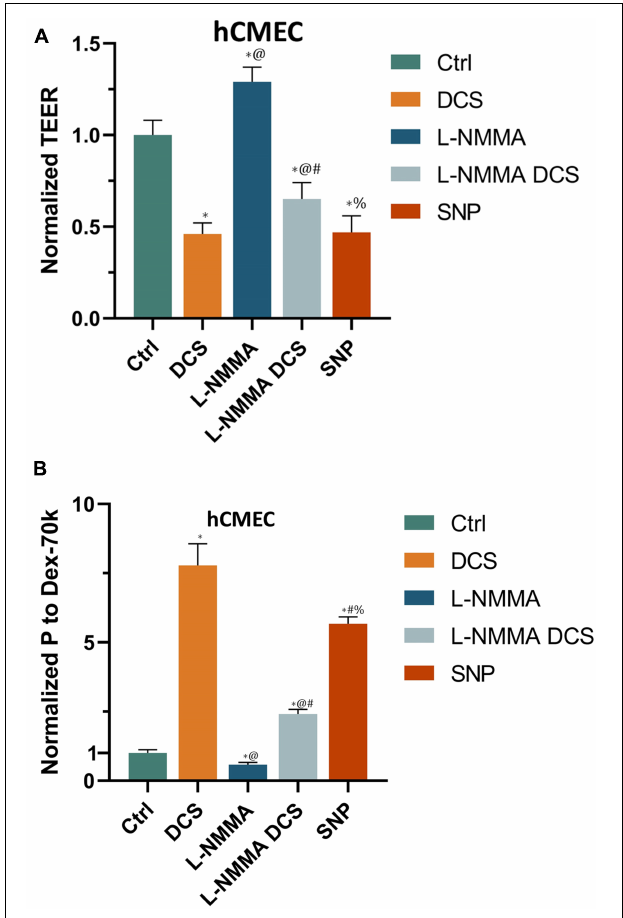
FIGURE 8 | Effects of a NOS inhibitor (L-NMMA) and a NO donor, sodium nitroprusside (SNP) on in vitro BBB TEER and permeability. (A) Normalized TEER and (B) normalized permeability to Dex-70K under control and after treatment of 10 min 1 mA/cm 2 DCS (DCS), or treatment of 60 min 1 mM L-NMMA, or pretreatment of 60 min 1 mM L-NMMA and treatment of 10 min 1 mA/cm 2 DCS (L-NMMA DCS), or treatment of 30 min 300 µ M SNP (SNP). n = 6 samples for each case in (A,B) . * p < 0.05, compared with the control, @ p < 0.05, compared with DCS, # p < 0.05, comparing L-NMMA DCS and SNP with L-NMMA, % p < 0.05, comparing SNP with L-NMMA DCS. The in vitro BBB was formed by hCMEC